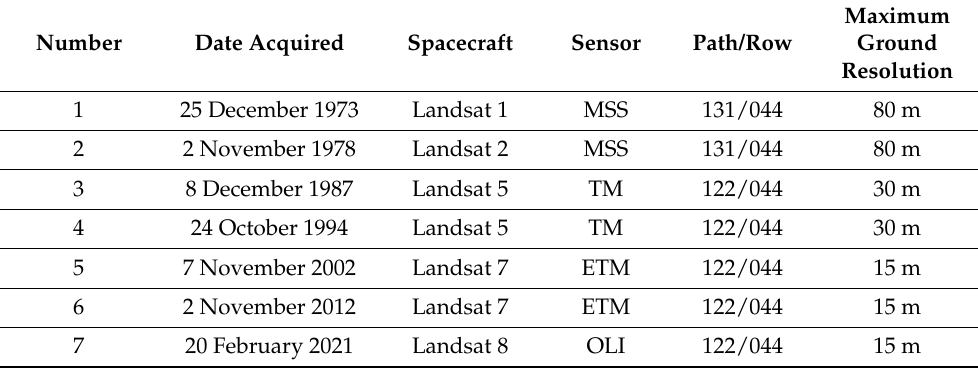
Table 1. Basic Attributes of Satellite Data in Typical Years in the Study